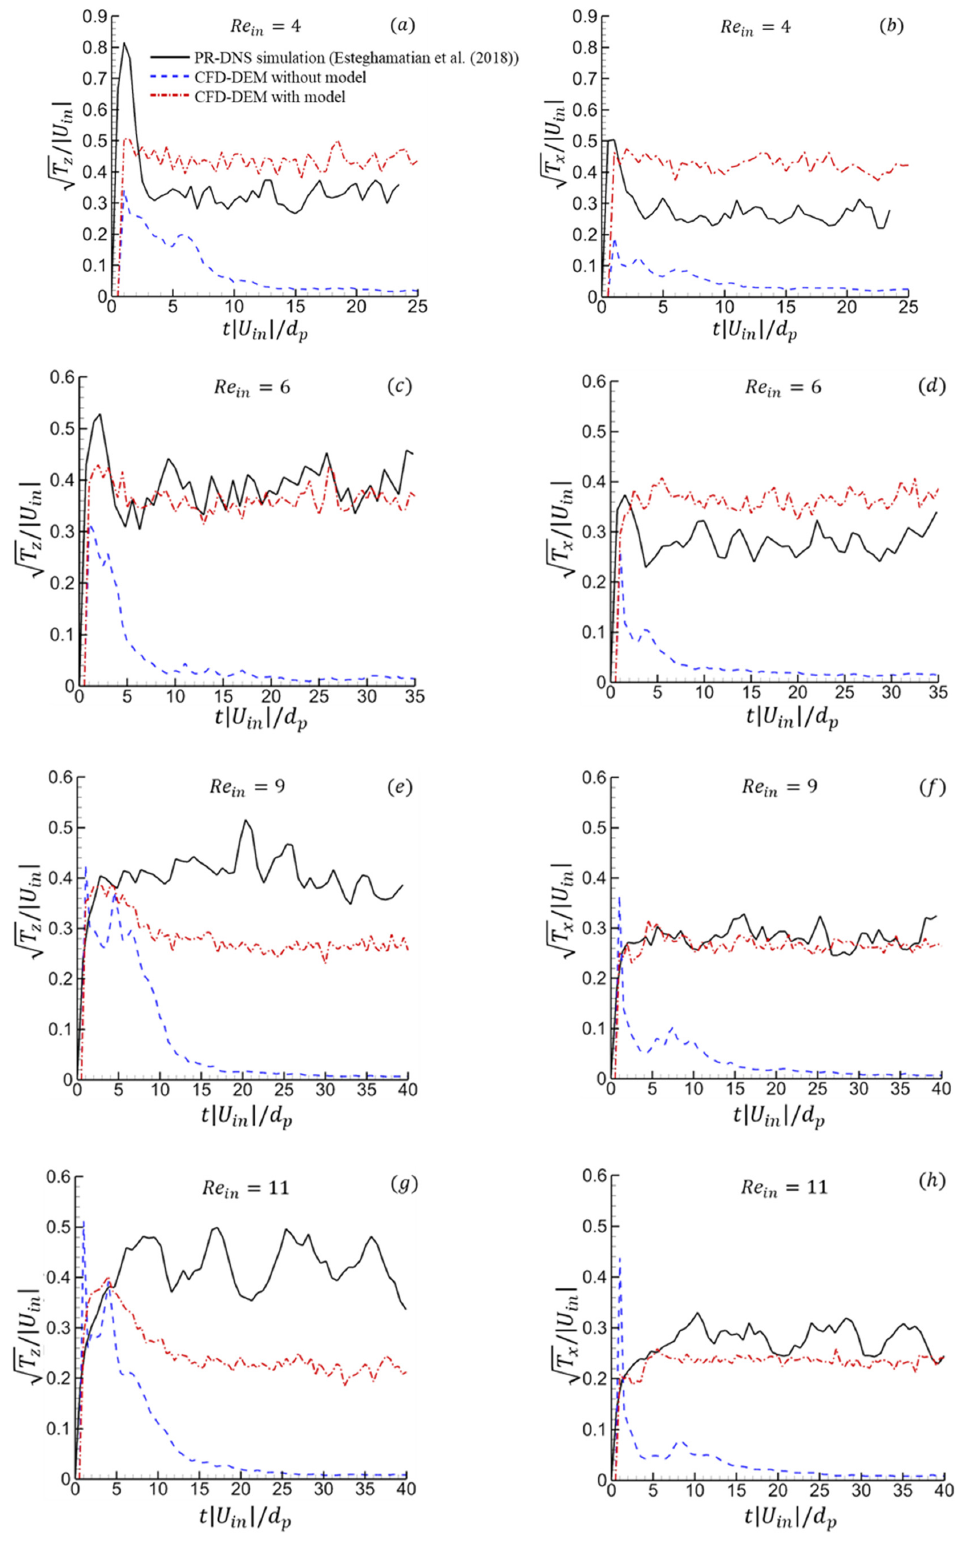
Figure 4. Comparisons of evolutions of vertical and lateral granular temperatures predicted from CFD-DEM simulations with and without the proposed model. PR-DNS results from Esteghamatian et al. [21] are also provided. The granular temperatures are scaled by the square of the inlet fluid velocity.